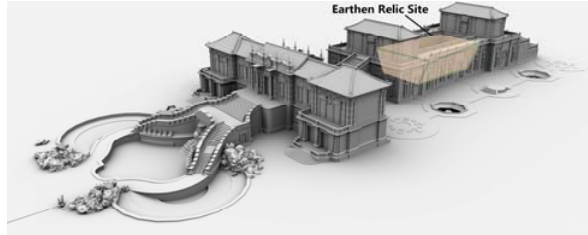
Figure 3. The Restored Map of Haiyan Hall